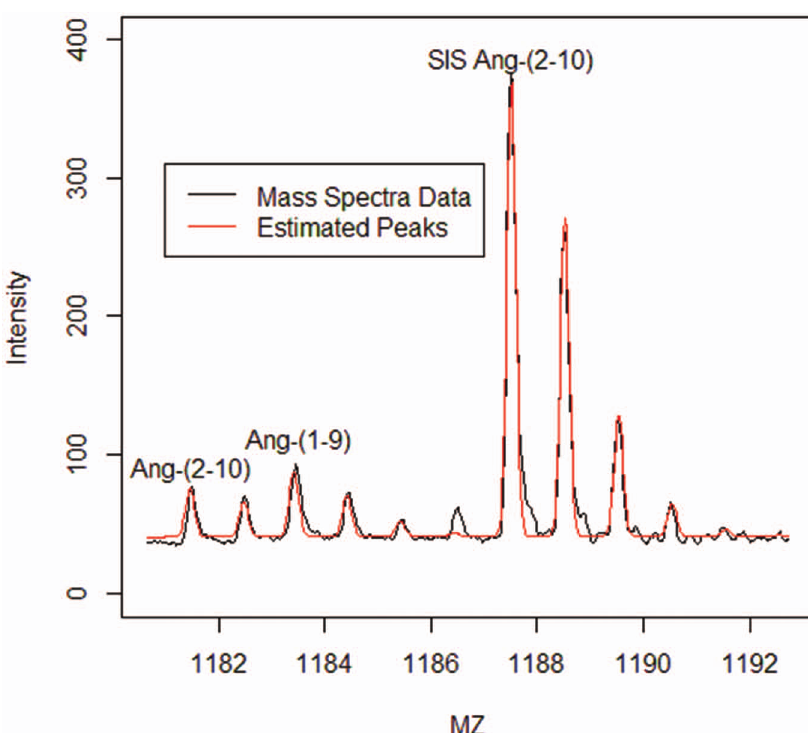
Figure 2. A MALDI-TOF mass spectrum from the analysis of Ang I extracellular breakdown [2] by rat glomeruli in the presence of amastatin (APA inhibitor) and thiorphan (NEP inhibitor) at 60 minutes. The sample contains a mixture of Ang-(2–10), Ang-(1–9), and SIS- Ang-(2–10) that overlap forming one cluster. These peaks are fit and the individual areas for each isotopic cluster can be decomposed from the